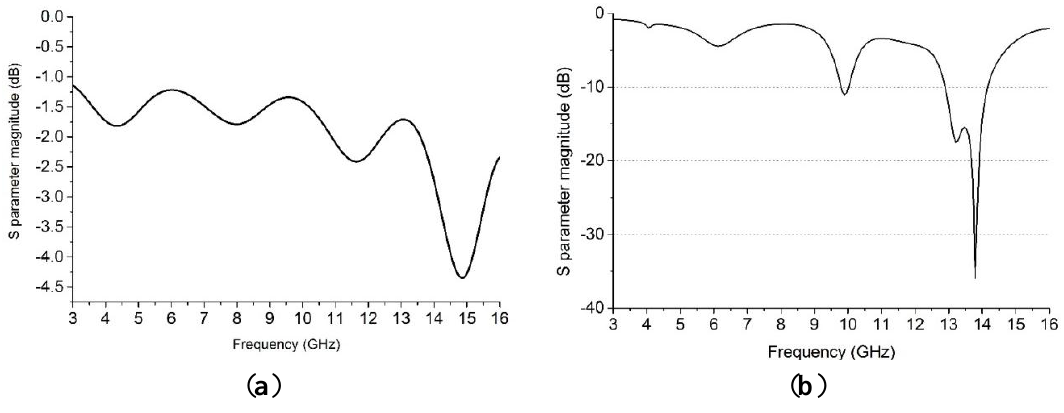
Figure 5. The reflection coefficient, S 11 , of the MTM antenna ( a ) one element ( b ) four